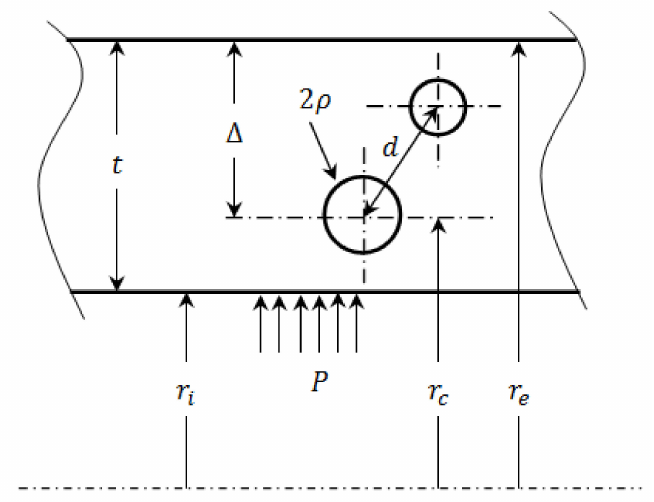
Figure 1. Distance between two spherical inclusions of different radii embedded in an isotropic- elastic